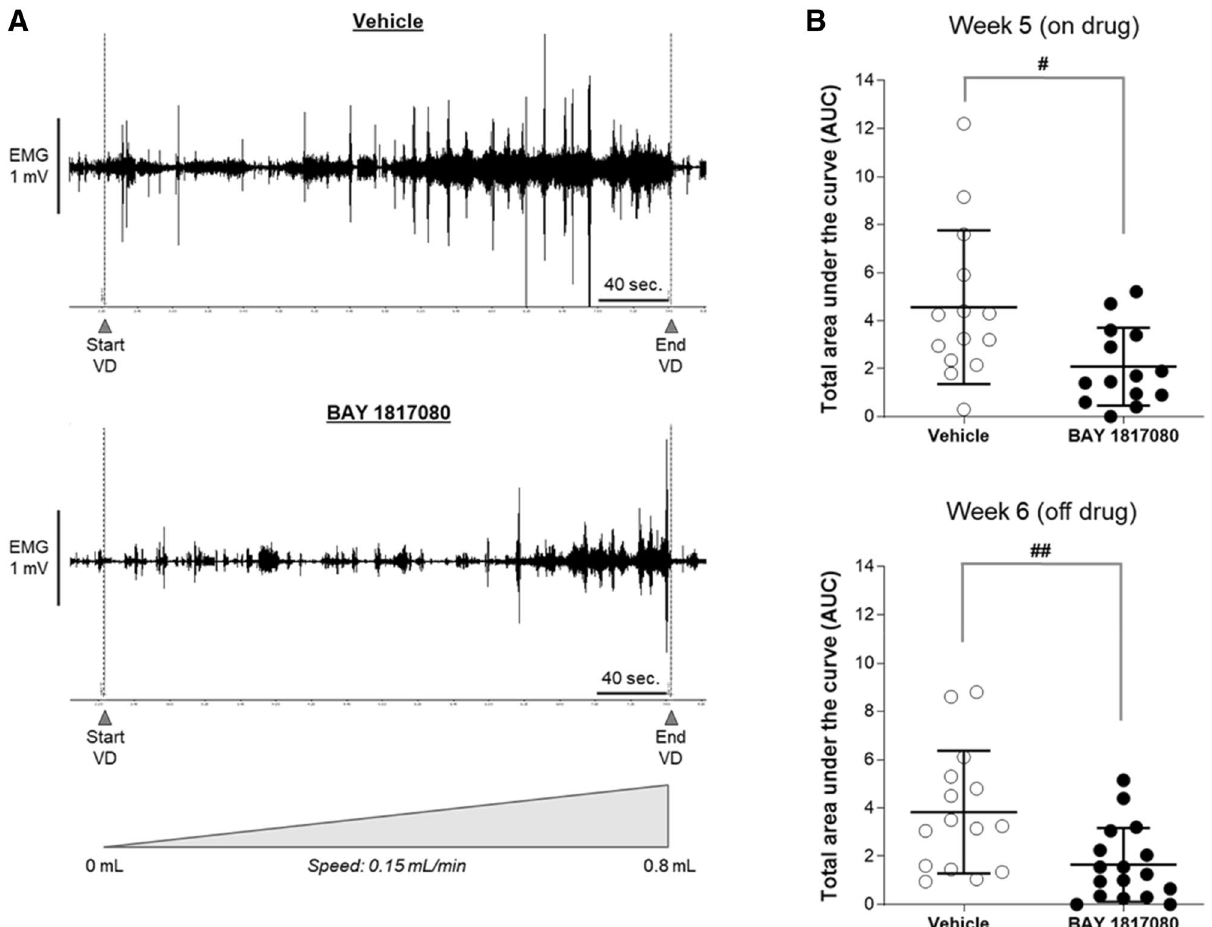
Figure 5. Eliapixant (BAY 1817080) shows efficacy in a rat model of dyspareunia. ( A ) In female Sprague Dawley rats, the visceromotor response (VMR) to vaginal distension (inflated vaginal balloon) was measured by counting the number of abdominal muscle contractions in conscious animals as an objective measure of vaginal sensitivity (individual records of VMR response to vaginal distension of one rat after vehicle and eliapixant, week six post-implantation). ( B ) Eliapixant (15 mg/kg) or the vehicle (0.5% carboxymethylcellulose [CMC]:Tween 80; 5 mL/kg) were dosed orally, twice daily in female rats (n = 15/17 per experimental group), during two consecutive weeks, from week four to week five post-implantation of the uterine horn pieces. VMR/ vaginal distension tests were performed at week five (on-drug) and week six (off-drug) post-implantation when animals were in the pro-estrus phase. The individual area under the curve (AUC, determined from a plot of the cumulative number of abdominal contractions against vaginal distension volume for each animal) and the mean ± SD for each group is shown. One outlier was removed from the eliapixant treatment group at week five (Grubb’s test); # P < 0.05, ## P < 0.01 versus vehicle (0.5% CMC:Tween 80), Mann–Whitney U